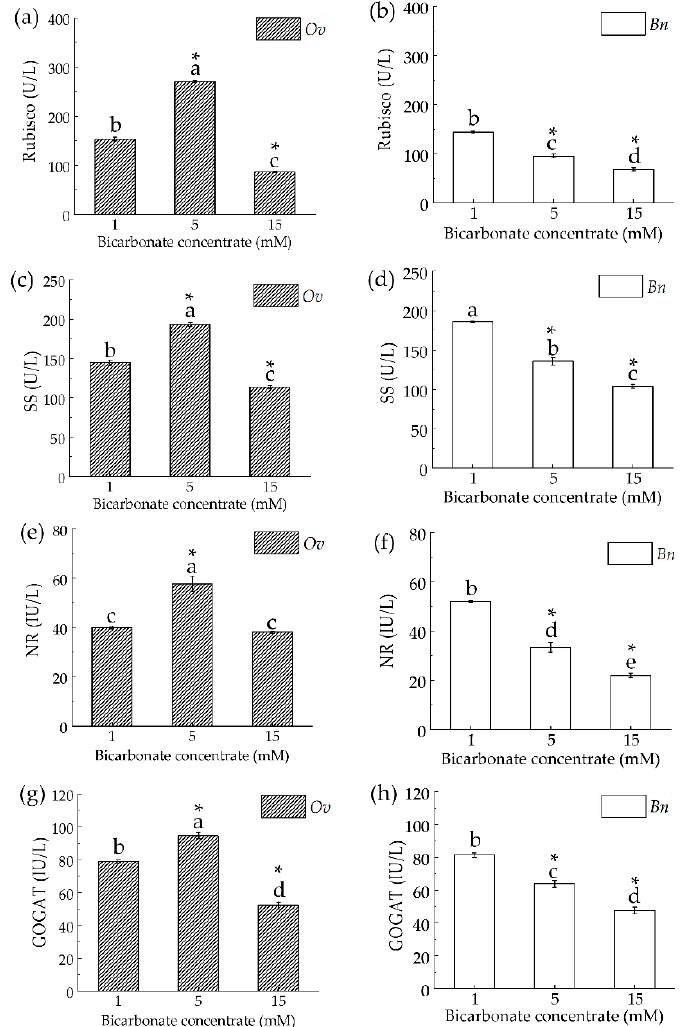
Figure 2. The responses of enzymes involved in carbon and nitrogen metabolism to bicarbonate in Ov and Bn . Ov—Orychophragmus violaceus and Bn—Brassica napus , Rubisco—ribulose bisphosphate carboxylase oxygenase, SS—sucrose synthetase, NR—nitrate reductase, and GOGAT—glutamate synthase. ( a , b ) — The Rubisico of Ov / Bn , ( c , d ) — The SS of Ov / Bn , ( e , f ) — The NR of Ov / Bn , ( g , h ) — The GOGAT of Ov / Bn . The ratio of nitrate/ammonium within consistent total nitrogen concentration was 14 mM:1 mM under various bicarbonate treatments. Each value represents the mean ± SD ( n = 3), and diverse letters with “*”in each value are significantly different by ANOVA ( p > 0.05).